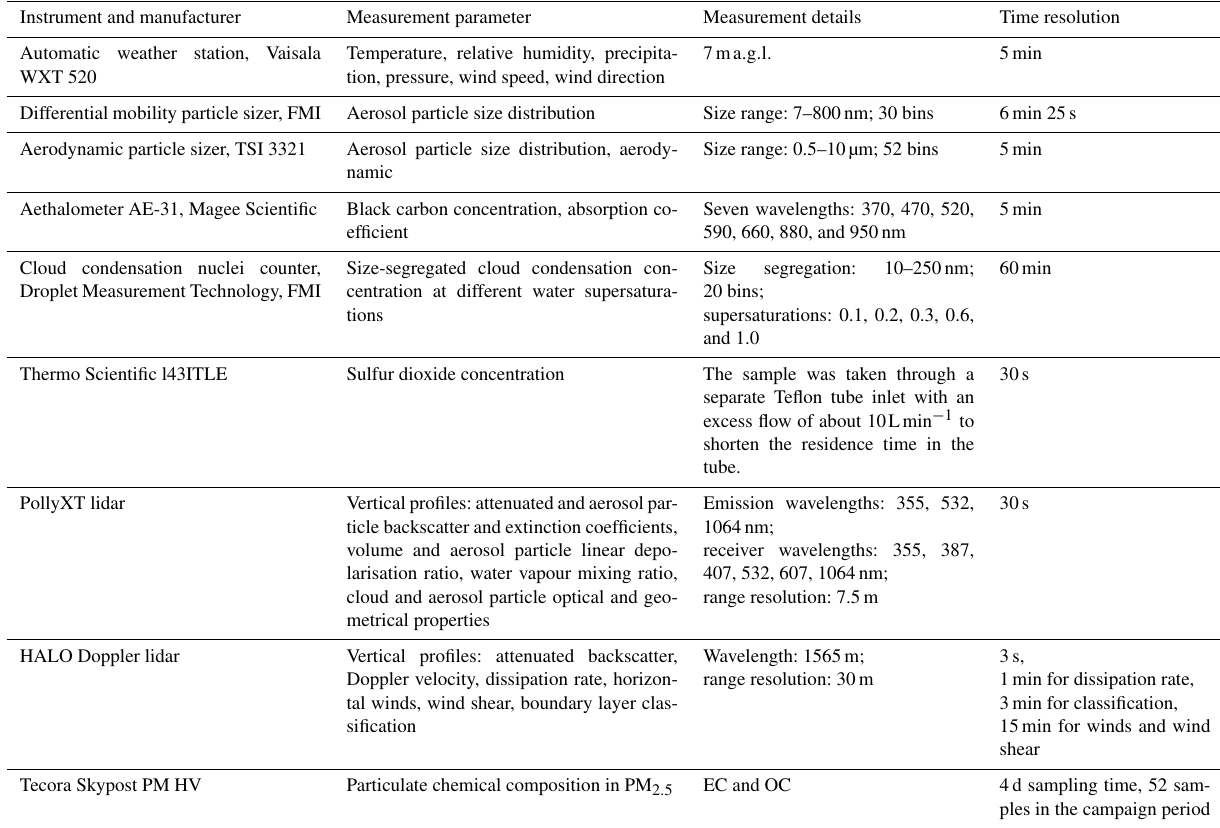
Table 1. Instruments operated during the measurement